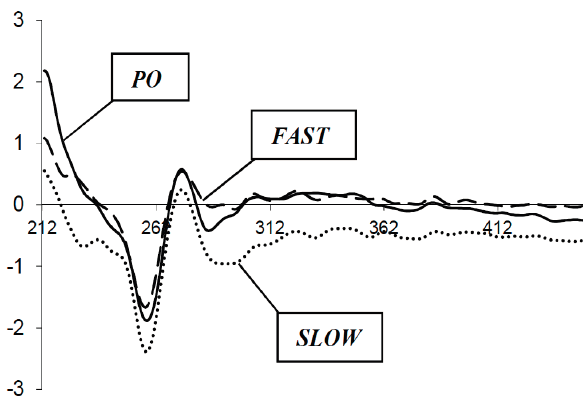
Figure 3. CD spectra of AQ-PO-dG, Fast and Slow forms of AQ-PS-dG